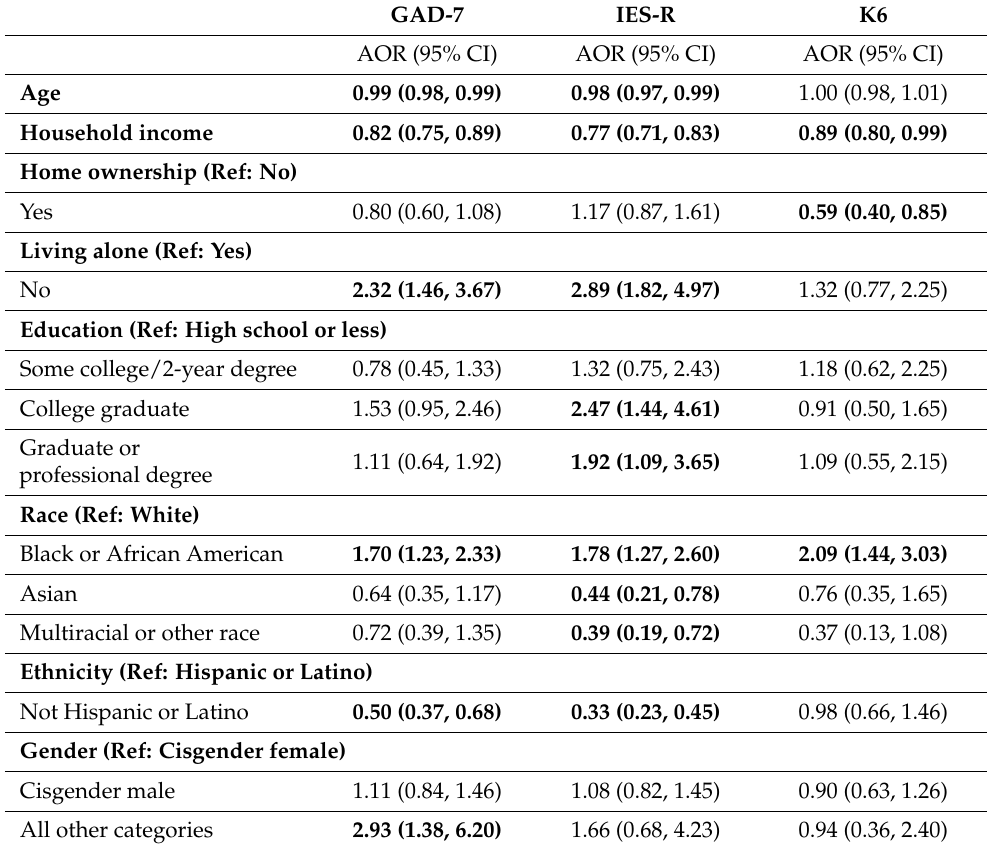
Table 3. Results of logistic regression models testing associations of sociodemographic characteristics with mental health symptoms. GAD-7